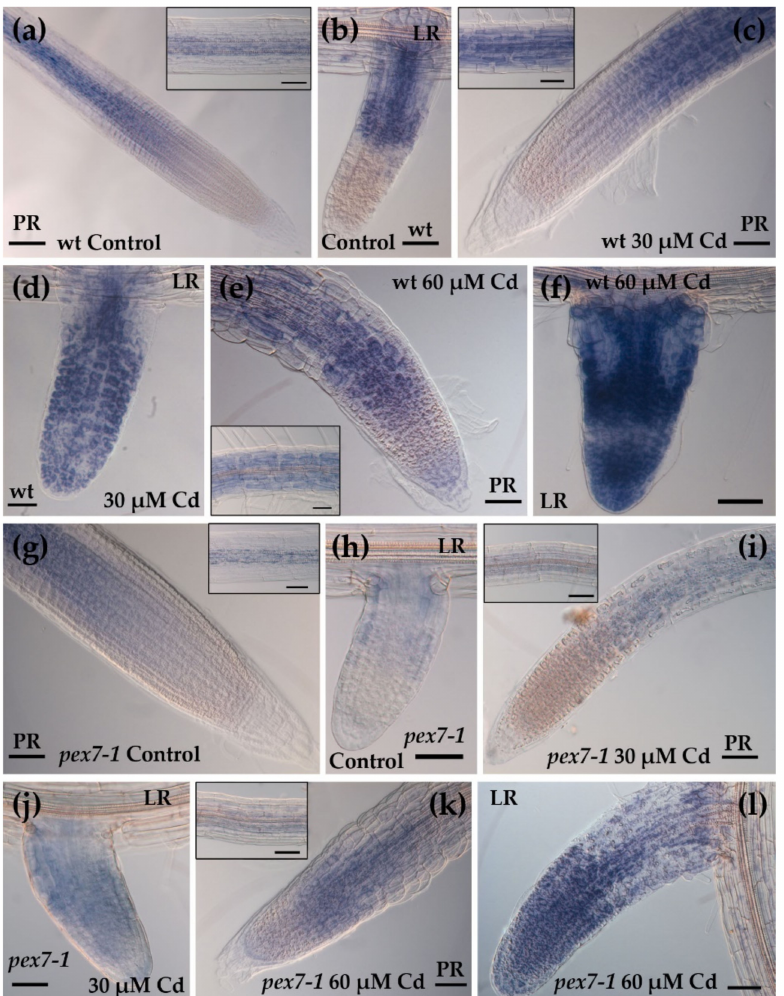
Figure 7. NBT histochemical analysis showing O 2 •− staining in the primary (PR) and lateral (LR) roots of wt ( a – f ) and pex7-1 ( g – l ) seedlings grown in the absence (( a , b , g , h ), Control) or in the presence of 30 µ M CdSO 4 (30 µ M Cd) ( c , d , i , j ) or 60 µ M CdSO 4 (60 µ M Cd) ( e , f , k , l ). The differentiation zone with xylary cells is shown in the insets. Images came from the three biological replicates. Bars = 100 µ m ( a ), 50 µ m (( b , c , f – l ), insets), 25 µ m ( d , e ). n =